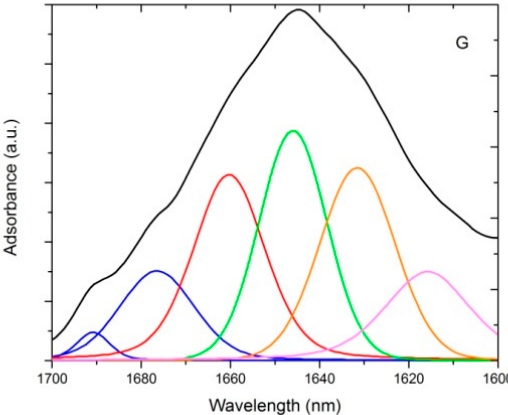
Figure 3. Amide I band with its underlying band subcomponents: α -helices (red), β -structures including β -sheets, β -turns, β -strands, etc. (blue), random coils or unordered structures (green), aggregates (orange), amino acid side chains (mandle) for RtH (30 mg/mL) in 50 mM sodium phosphate buffer ( A ) and in the presence of 0.2 M [Chol][Lys] ( B ), [Chol][Arg] ( C ), [Chol][Glu] ( D ), [Chol][Asp] ( E ), [Chol] 2 [Glu] ( F ), or [Chol] 2 [Asp] ( G ). The share/portion of each component is expressed as a percentage of the total amide area. The changes in the secondary structure of RtH due to its interactions with the ILs are illustrated in Figure 4 for a comparison.